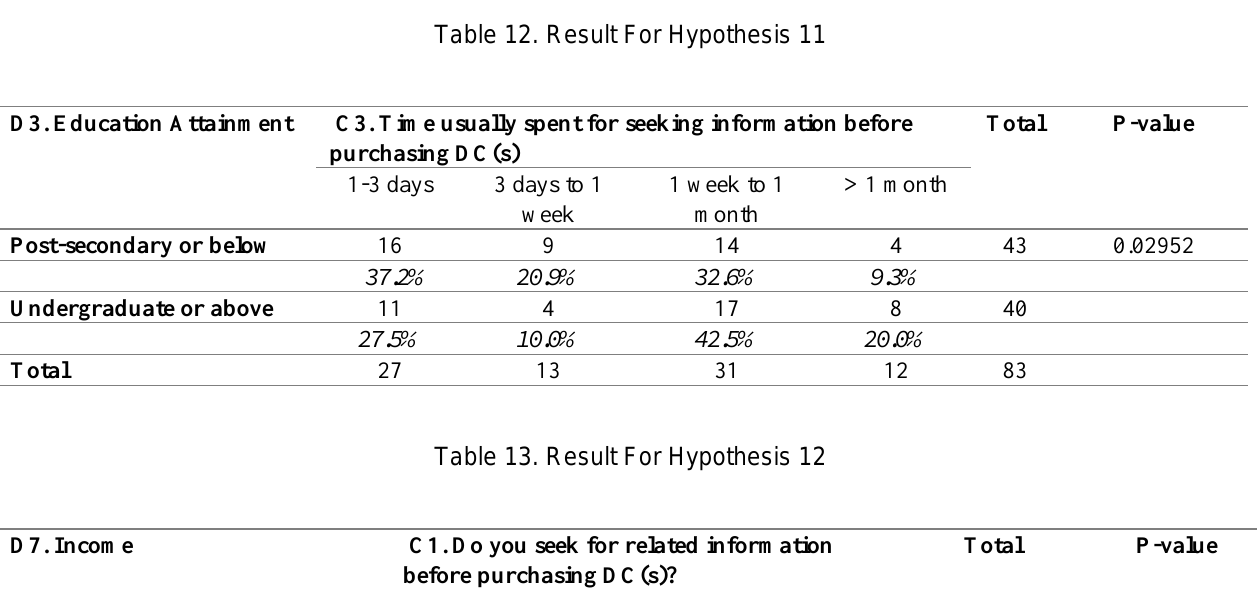
Table 12. Result For Hypothesis 11